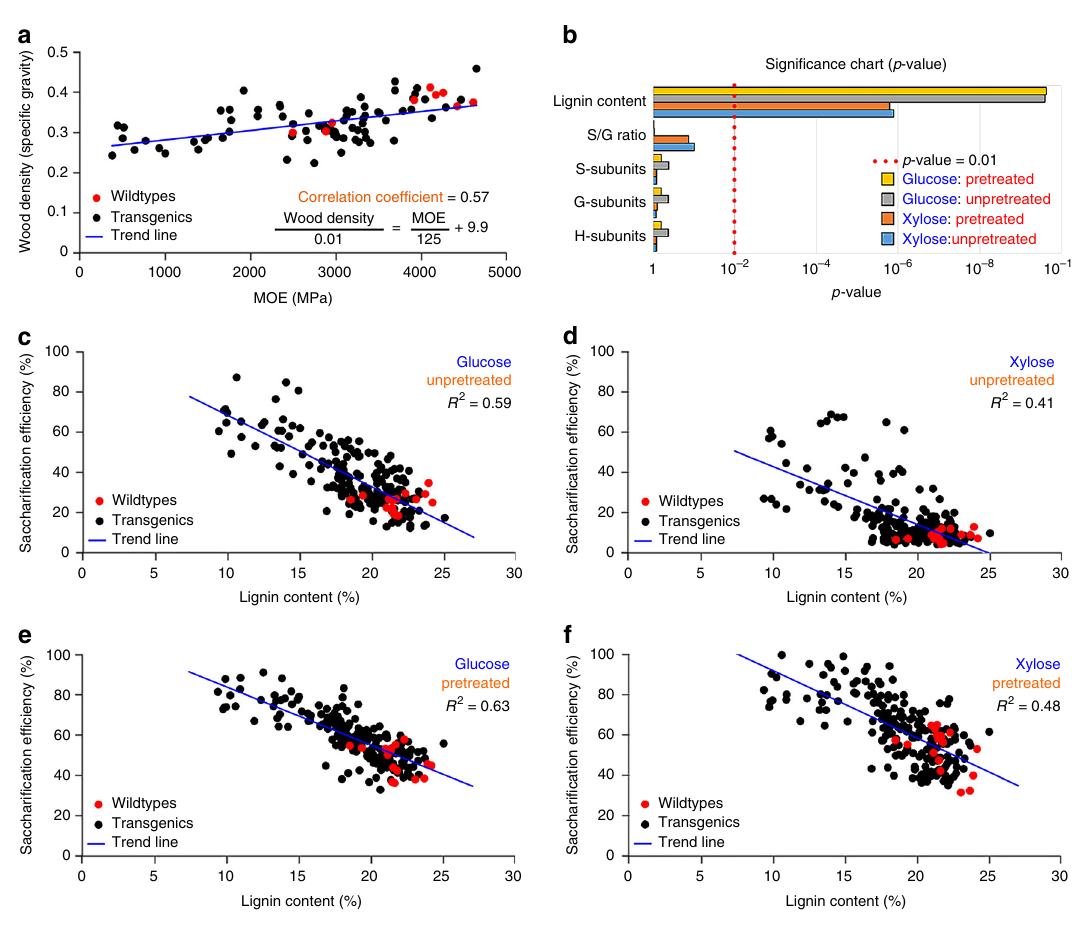
Fig. 7 Quantitative relationships between wood relative density, MOE, lignin content, and sacchari fi cation ef fi ciency. a The relationship between experimentally measured wood density and MOE. Each dot represents a replicate pool of one wildtype (red dots) or transgenic (black dots) line containing 3 – 5 clonally propagated plants. MOE and wood density show a positive linear relationship with a correlation coef fi cient of 0.57. Linear regression shows that each 0.01 increase in wood density corresponds to a 125 MPa increase in MOE. b Signi fi cance chart ( p -value) shows that among the lignin properties, lignin content is the only signi fi cant effector ( p < 0.01) of wood sacchari fi cation ef fi ciency. The fi ve highest p -values and the corresponding lignin properties are shown. c – f Wood sacchari fi cation ef fi ciency is negatively correlated with lignin content. Scatterplots show the percentage release of glucose ( c , e ) and xylose ( d , f ) in the transgenic (black dots) and wildtype (red dots) P. trichocarpa . The wood samples were either unpretreated ( c , d ) or hot-water pretreated ( e , f ) (Methods). Each dot represents a replicate pool of one wildtype or transgenic line containing 3 – 5 clonally propagated plants. R 2 denotes